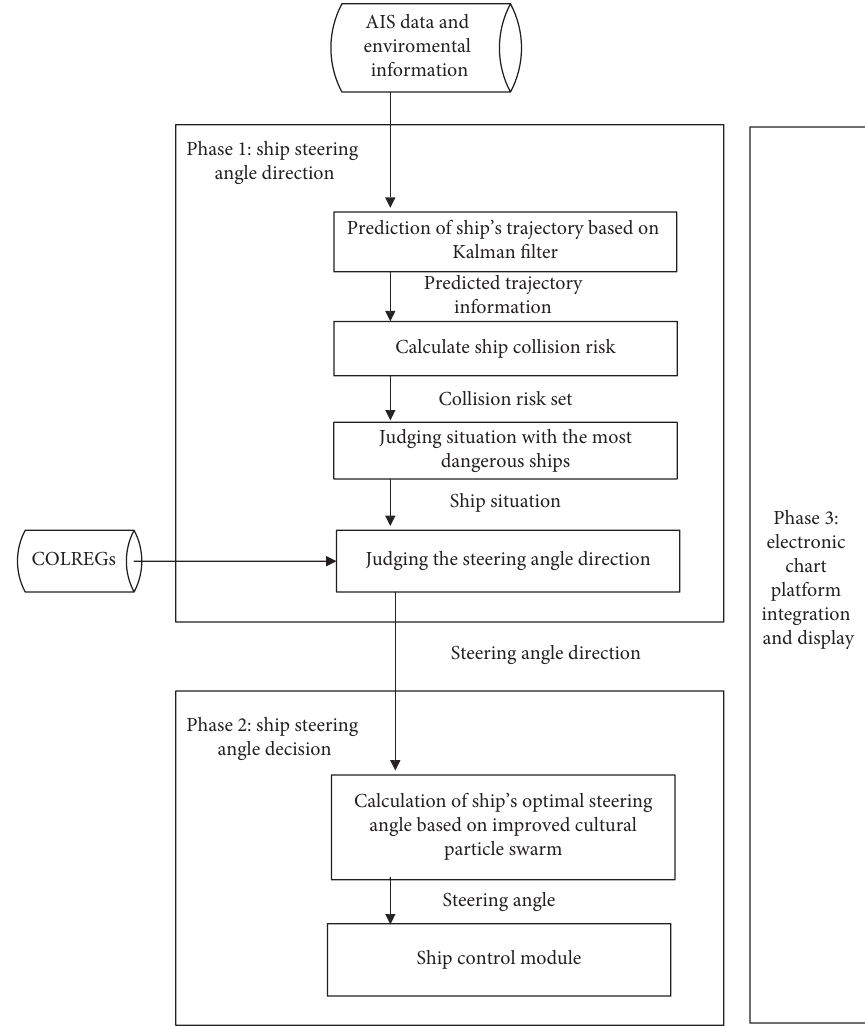
Figure 1: A ship collision avoidance decision framework based on cultural particle